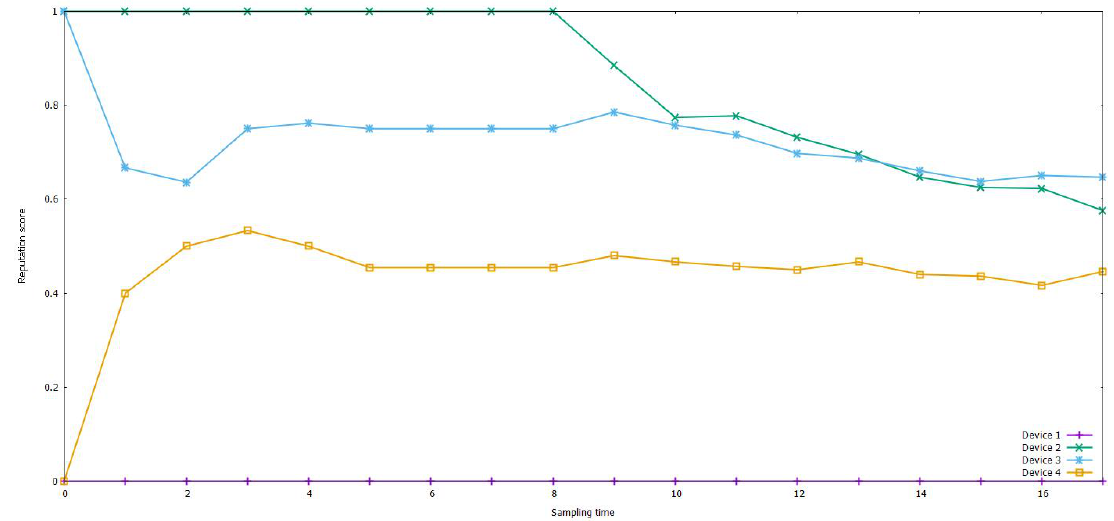
Figure 10. Sensor value reputation of each device, obtained in test